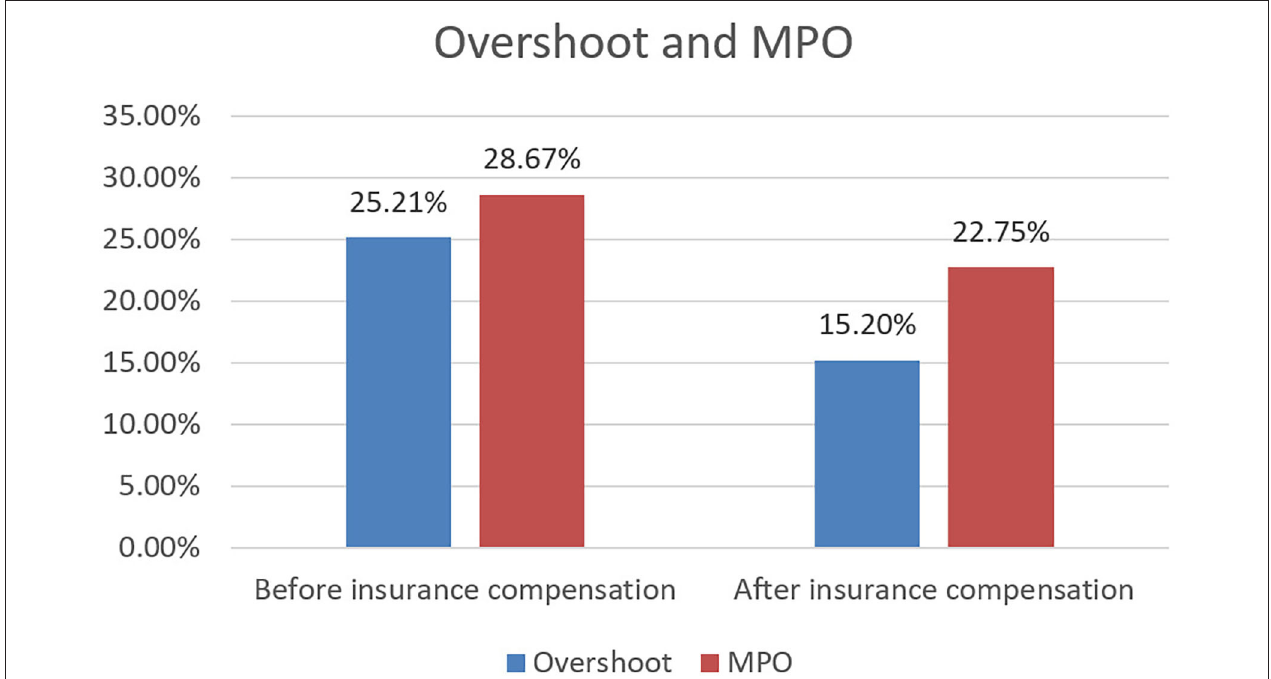
FIGURE 1 | Intensity of CHE before and after insurance compensation. The Overshoot is the average distance, it reflects the intensity of CHE in the overall households with cancer patients. The MPO represents mean relative distance, it indicates the intensity of CHE in the households suffering from CHE.